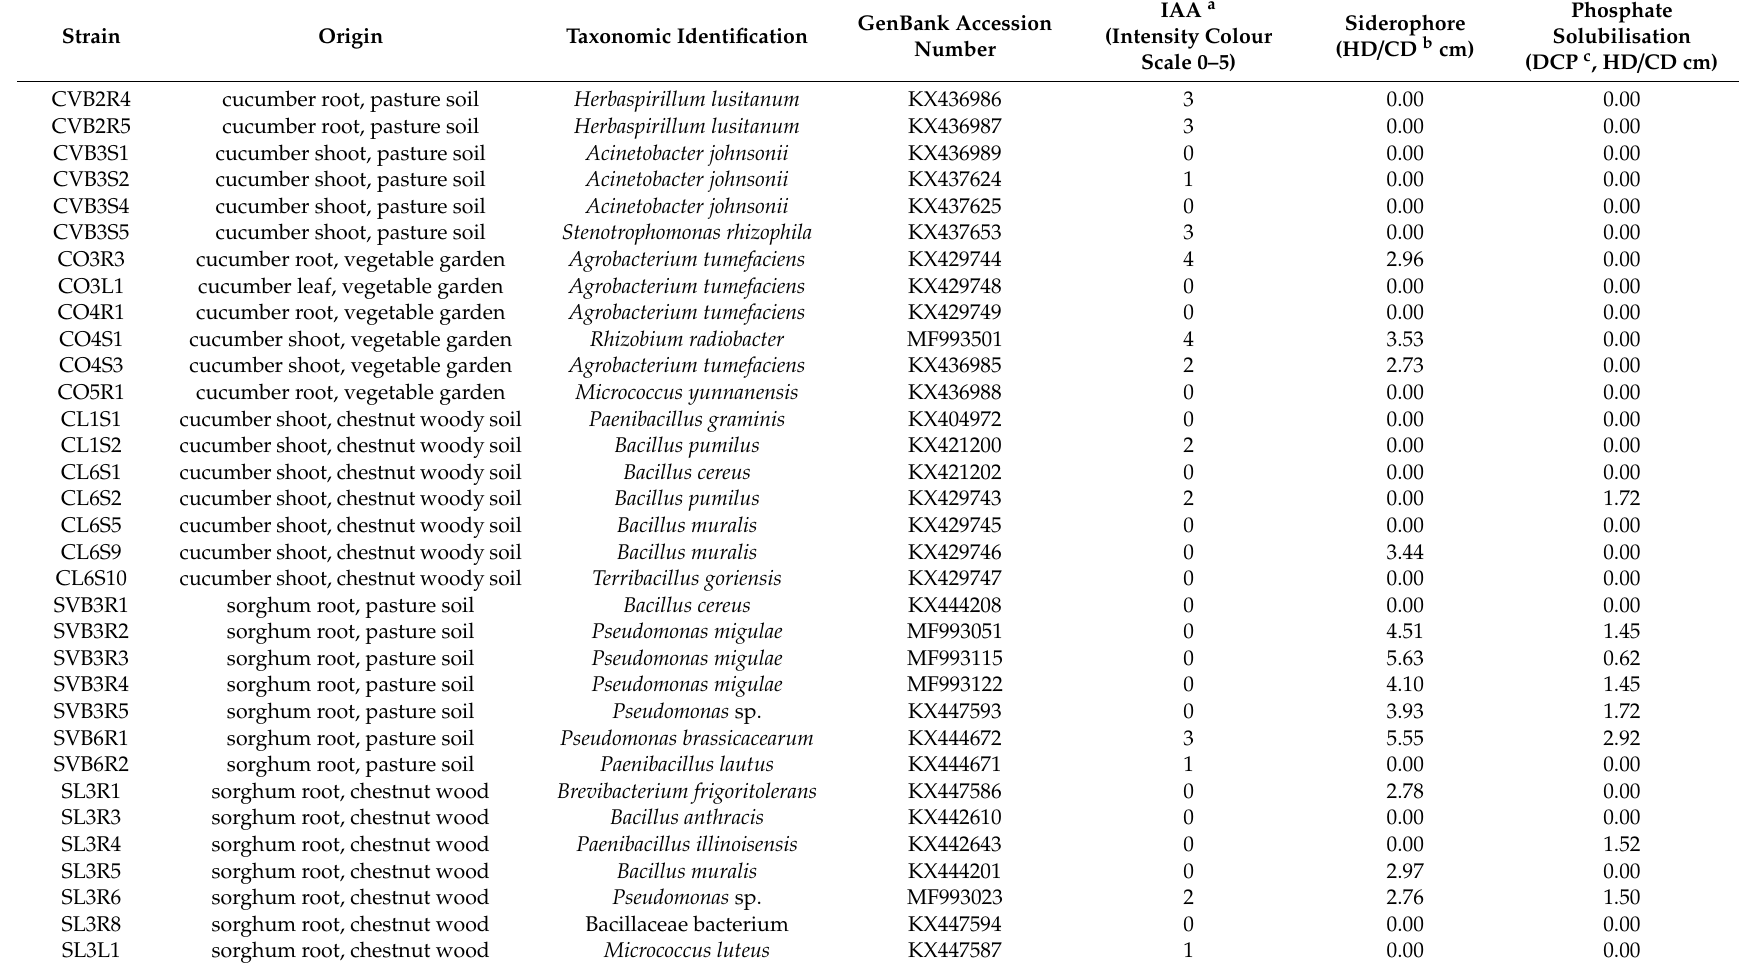
Table 1. List of bacterial strains isolated from internal plant tissues and characterization of plant-beneficial physiological activities.